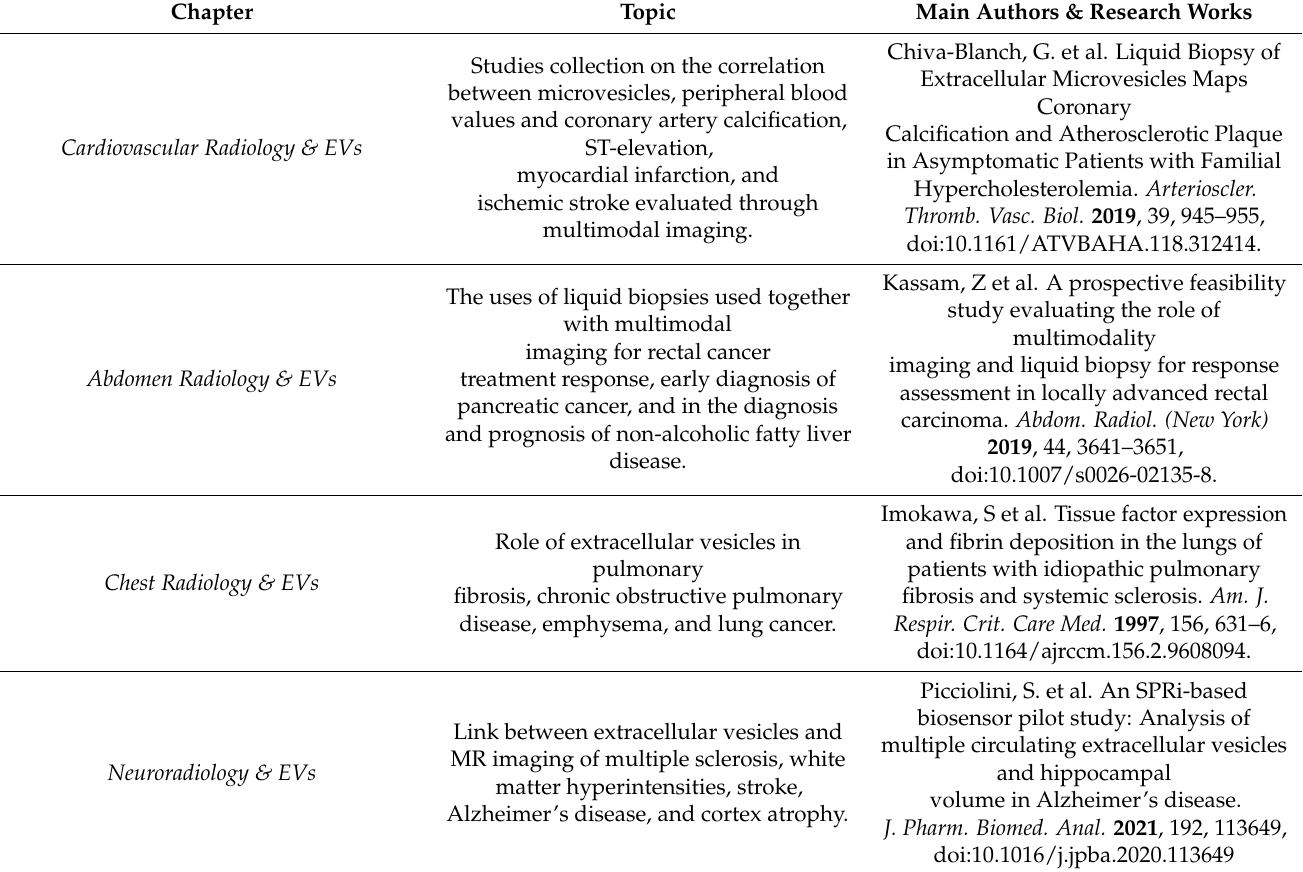
Table 1. Summary table of the major topics explained in the subsequent